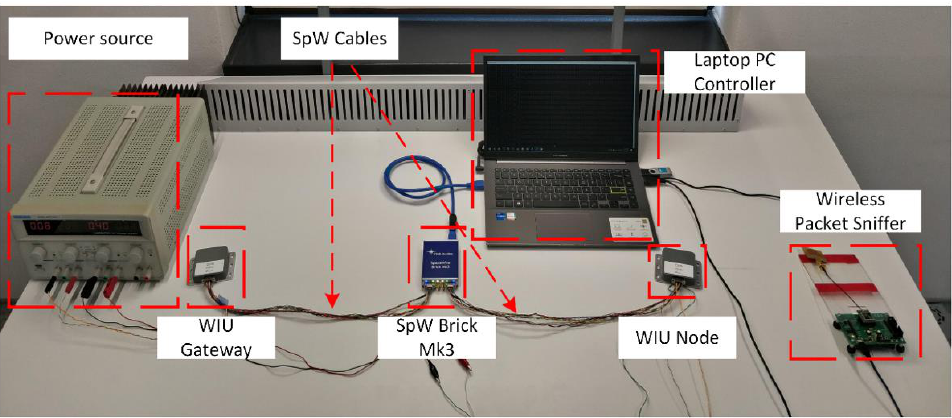
Figure 6. Testbed implementation (on Control Data Systems premises in Cluj-Napoca, Romania).